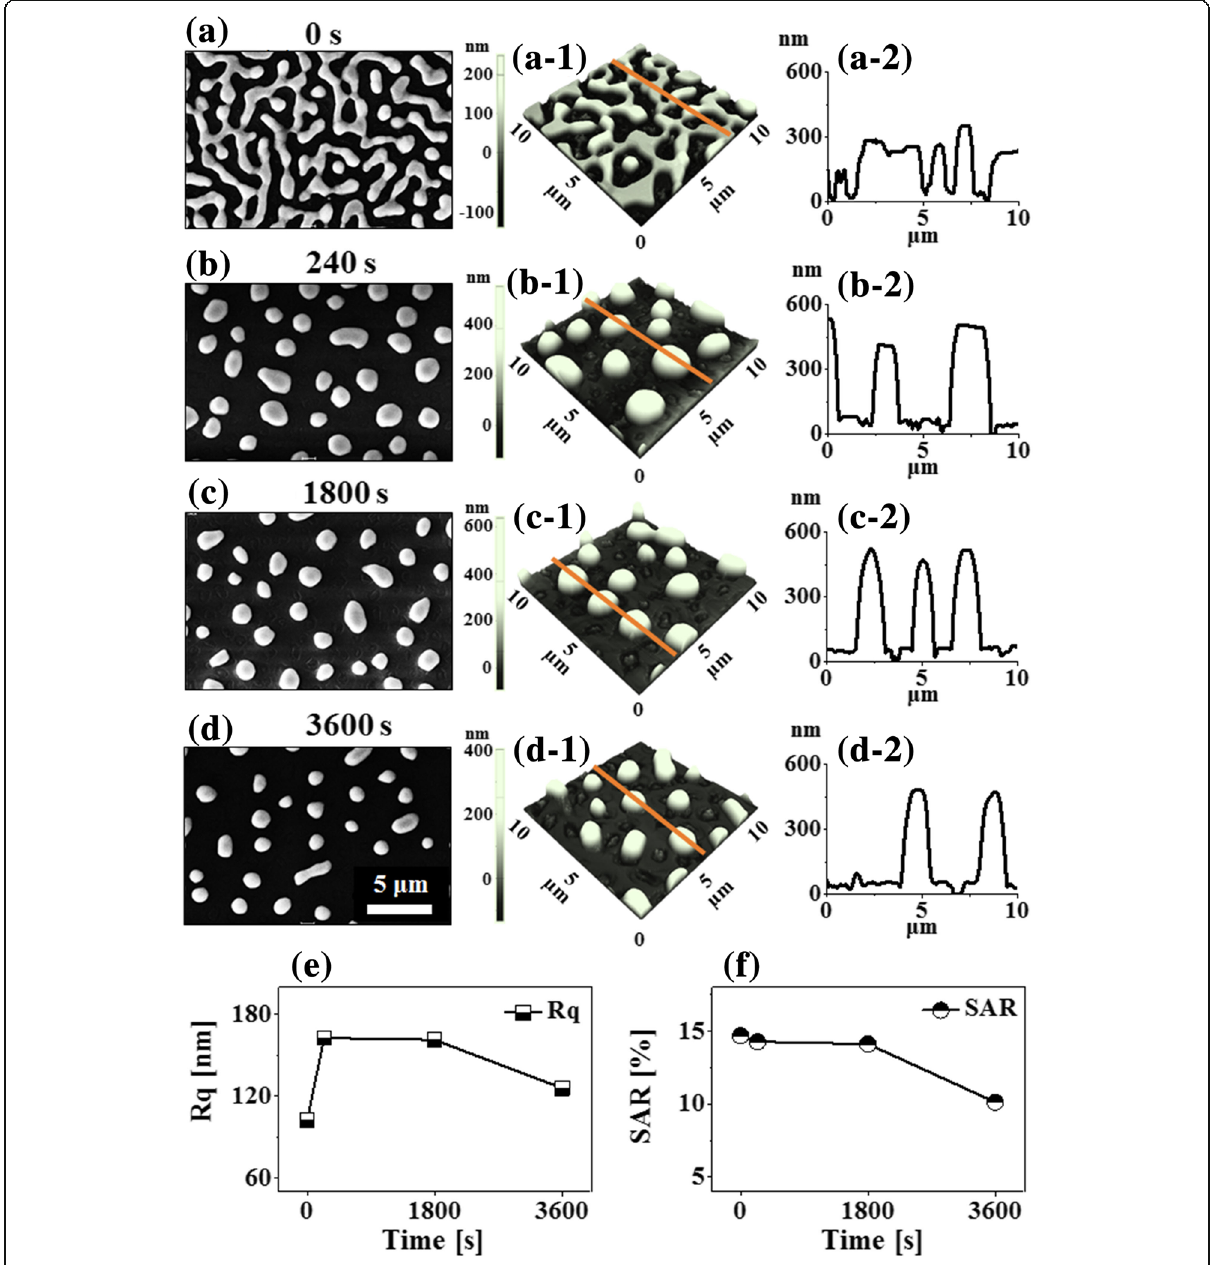
Fig. 6 Fabrication of bi-metallic PdAg nanostructures on saaphire (0001) by the control of annealing time with the Pd 150 nm /Ag 80 nm bi-layers annealed at 850 °C (bi-layers). a – d SEM images. a-1 – d-1 Corresponding AFM side-views (10 × 10 μ m 2 ). a-2 – d-2 Cross-sectional line profiles. e , f Plots of Rq and